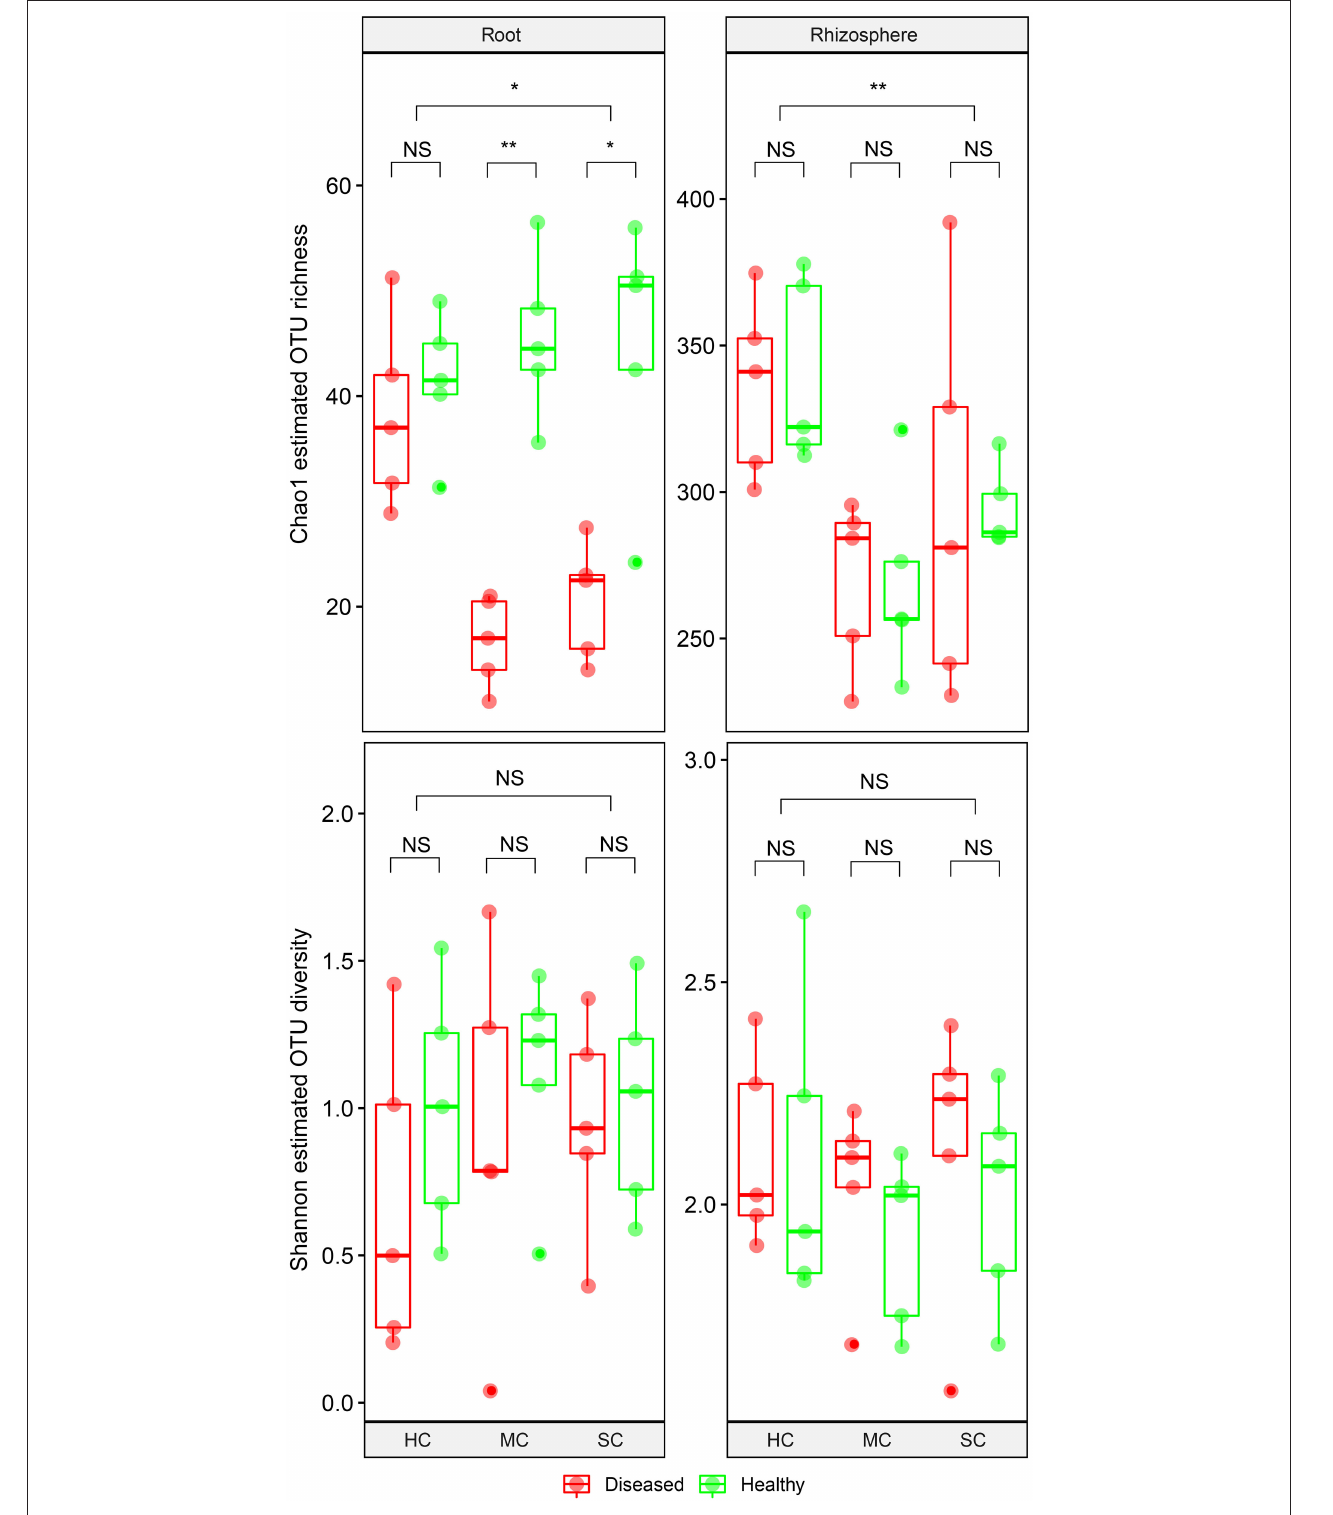
FIGURE 3 | Boxplot showing alpha diversity estimation of the fungal communities including the Chao1 richness estimator and Shannon diversity index. The points represent samples from diseased (D) and healthy (H) watermelon of different cultivars (HC, highly resistant cultivar; MC, moderately resistant cultivar; SC, susceptible cultivar) from root and rhizosphere. Upper, middle, and lower lines represent first quartiles, medians, and third quartiles. The whiskers represent a 1.5 * inter-quartile range. * P < 0.05; ** P ≤ 0.01; and NS, not statistically significant.